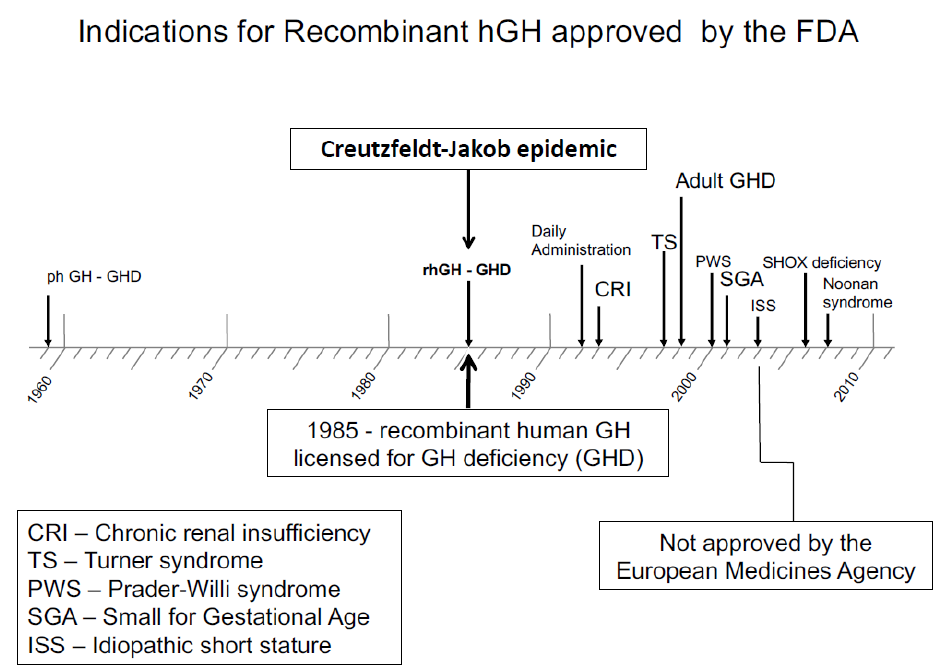
Figure 2. Indications for recombinant hGH therapy approved by the FDA after 1985